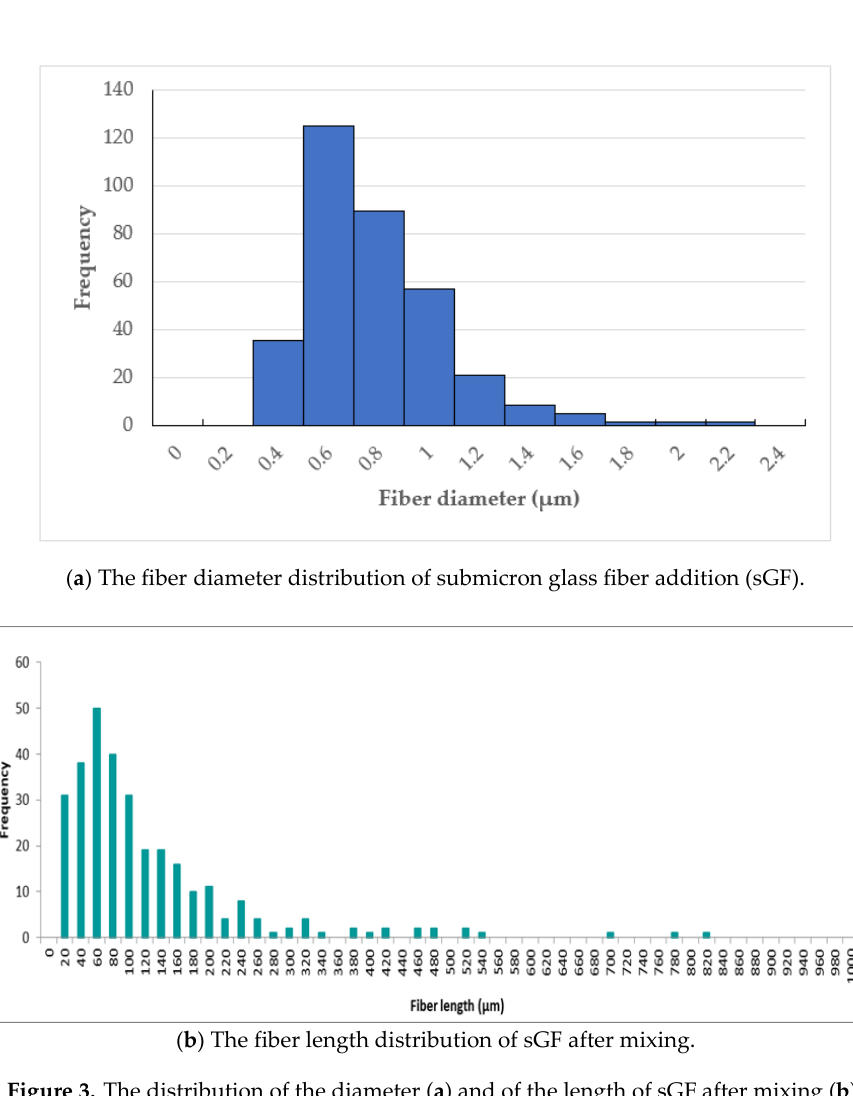
Figure 3. The distribution of the diameter ( a ) and of the length of sGF after mixing ( b ).